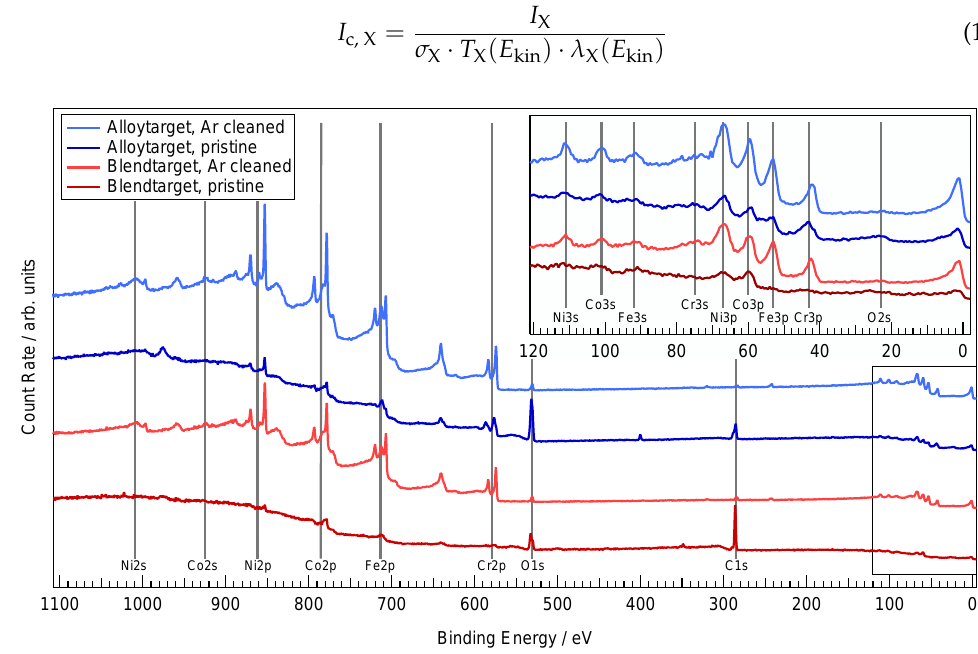
Figure 1. X-ray photoelectron spectroscopy survey spectra obtained for the two sputter targets before and after Ar + bombardment. The inset shows a zoom-in of the binding energy range up to 120eV, which is densely populated by the 3s and 3p core level signals of the involved